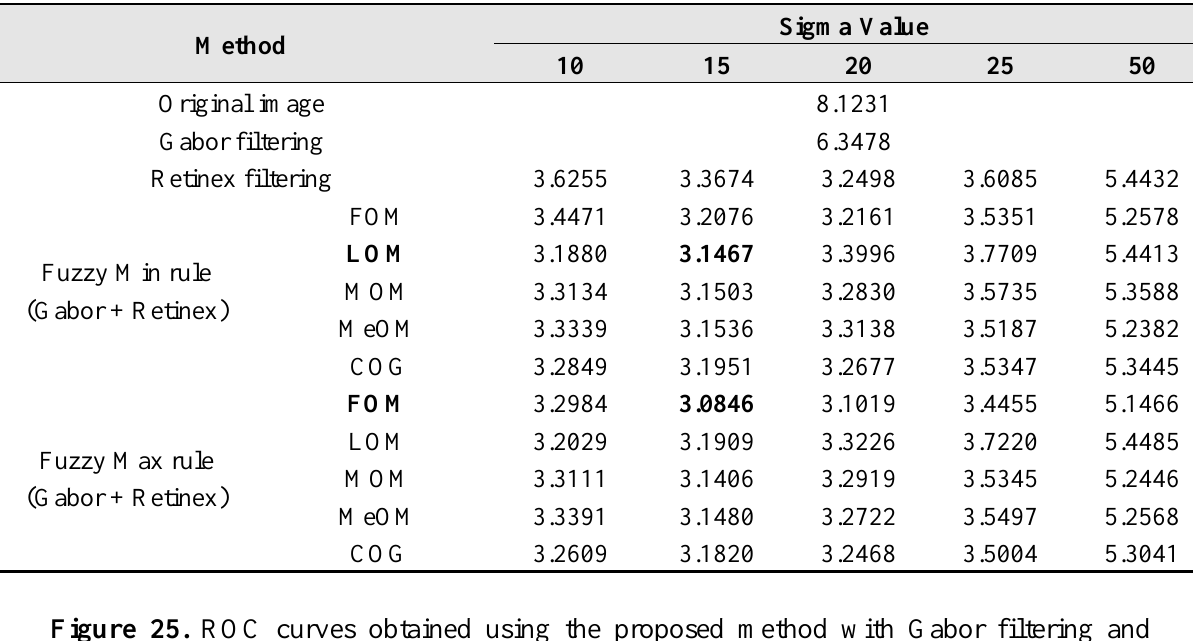
Figure 25. ROC curves obtained using the proposed method with Gabor filtering and Retinex filtering, with a sigma value of 15, and a LBP operator for images from database